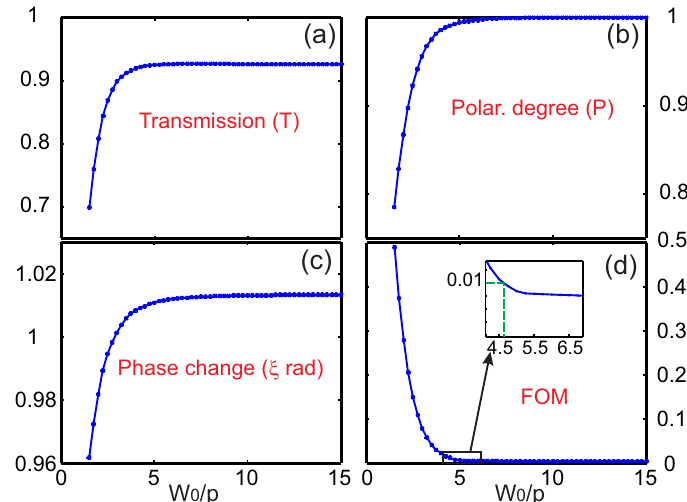
Figure 3. Variations of ( a ) the transmission efficiency T , ( b ) the polarization degree P , ( c ) the phase change ξ and ( d ) the FOM defined by Equation (10) in the case of the half-wave plate operating at λ = 1.194 p as a function of the illumination Gaussian beam size W 0 / p . The beam is impinging the structure under normal incidence and is polarized at 45 ◦ from the x -axis in order to get transmission across the two perpendicular rectangles. The angular spectrum expansion of the beam is described with 128 × 128 harmonics. The inset in (d) corresponds to a zoom made around FOM = 10 − 2 .